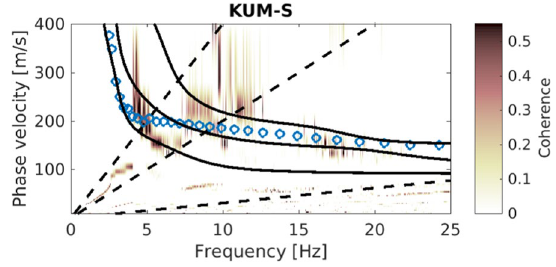
Fig. 9 Passive MASW; Theoretical Rayleigh wave phase velocity dispersion curves (black curves) on top of KUM-S MASW image. The misinterpreted results submitted at Step 1 (blue circles) are also